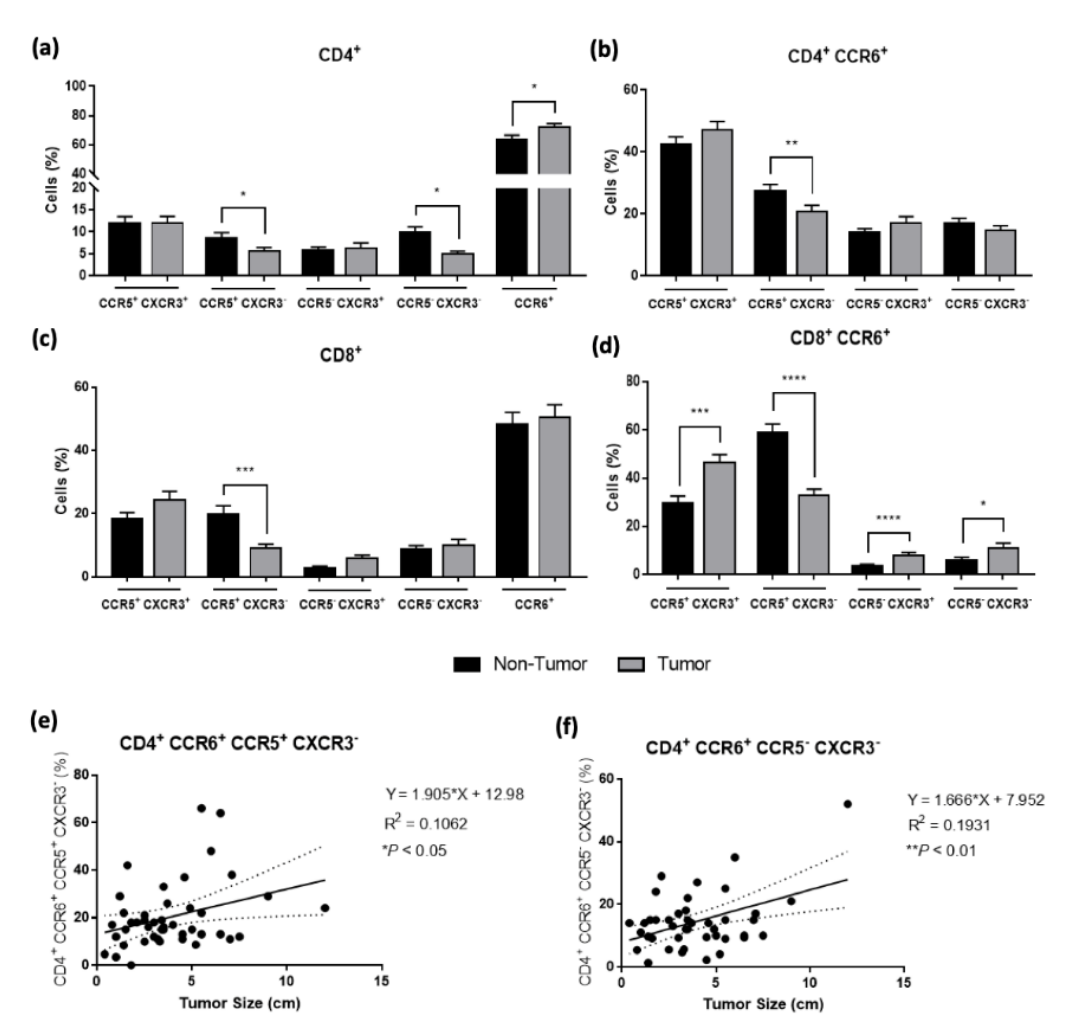
Figure 4. Flow cytometry analysis of T-cell functional phenotypes. Frequencies of the different functional CD4 + ( a ) or CD8 + ( c ) T-cell subsets based on the expression of CCR5, CXCR3, and CCR6. ( b ) Analysis of CD4 + CCR6 + and ( d ) CD8 + CCR6 + T-cell subsets. All results are